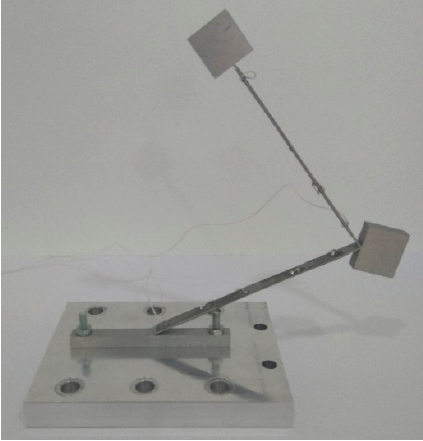
Figure 13. Prototype of bidirectional piezoelectric energy harvester.